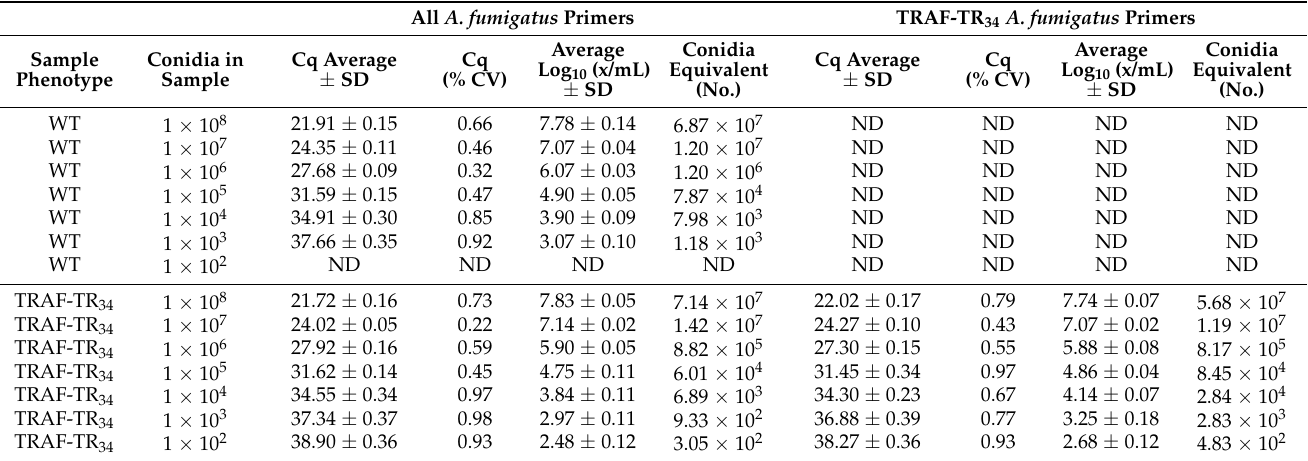
Table 1. qPCR reaction characteristics and determination of the conidia equivalent copy number of the predicted specific single copy cyp51A